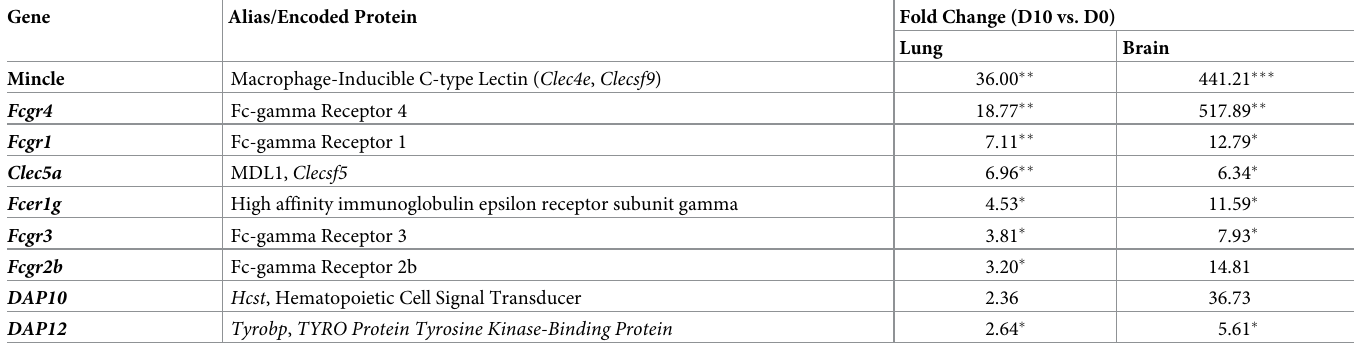
Fold changes compared with mock controls. �